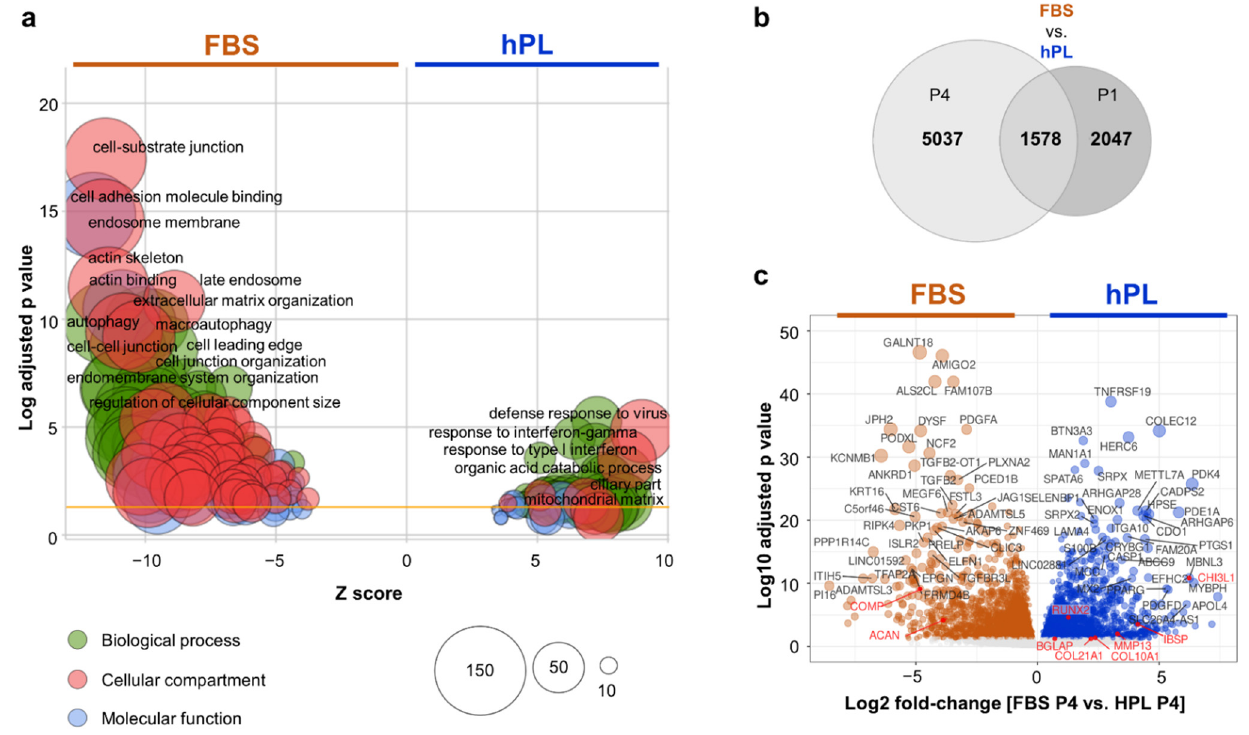
Figure 3. Predominantly regulated pathways. ( a ) Gene Ontology (GO) enrichment analysis compar- ing hPL-(right side) or FBS-driven cultures (left side). We labelled only the top 12 FBS- and, with significantly lower adjusted p -value, top 6 hPL-enriched GO terms. A higher absolute Z-score indi- cates a stronger level of enrichment. The yellow line indicates the adjusted p -value of 0.05. Biological process, cellular component and molecular function GO categories are highlighted in green, red and blue, respectively. Circle size represents number of genes found in the respective GO term category. Only genes commonly differentially regulated and showing the same direction (both passages UP or DOWN in hPL) irrespective of culture duration (1540 out of 1578 in the central component, in ( b ), were analyzed. ( b ) Venn diagram showing the number of differentially expressed genes in cells obtained by hPL- vs. FBS-driven culture for P4 and hPL vs. FBS for P1 (adjusted p -value < 0.05). ( c ) Volcano plot showing most significantly expressed genes in FBS- (left) and hPL-driven cultures (right). Red dots marking genes significantly differentially expressed (adjusted p -value < 0.05); black dots, not significant. Most significantly differentially expressed genes indicated by gene